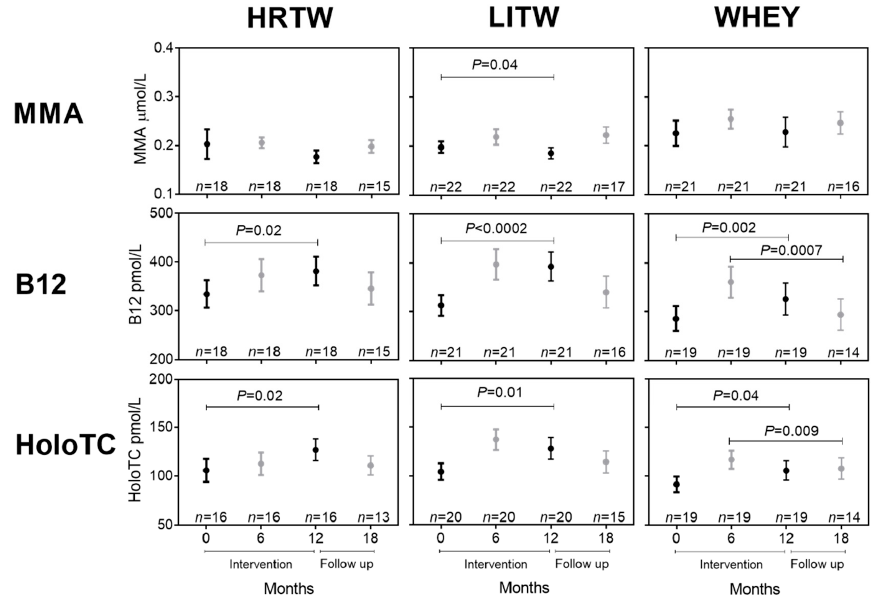
Figure 3. Changes in markers of B12 status in response to training intervention in combination with whey supplementation. Healthy older participants received one year of intervention with whey in combination with heavy resistance training (HRTW), light resistance training (LITW), or no added training (WHEY). Plasma concentrations of MMA, B12, and holoTC at baseline and after six months (6 mo) and 12 months (12 mo) of intervention and again after a six months follow-up period (18 mo) are shown as means with their standard errors. The number of observations is indicated ( n = x). Plasma samples were obtained in the overnight fasted state at baseline and 12 mo (black symbols), where the nutritional state was not controlled at 6 mo and 18 mo (grey symbols). Therefore, the statistical comparisons are made pairwise within each of the states, and the statistical di ff erences between fasting blood samples (baseline vs. 12 mo, black) and between non-fasting blood samples (6 mo vs. 18 mo, grey) were estimated with the paired t-test or the Wilcoxon signed-rank test (non-normal data). Abbreviations: B12, vitamin B12; holoTC, holotranscobalamin; MMA, methylmalonic